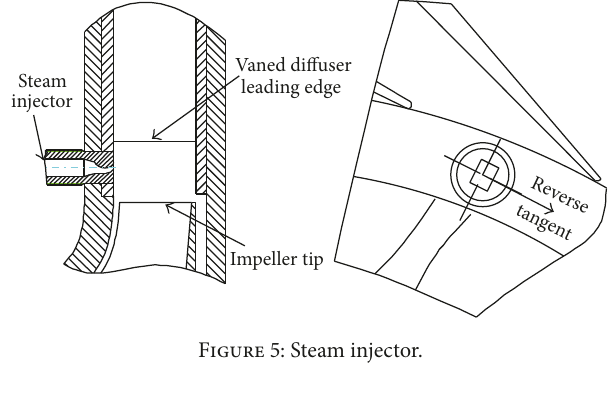
Figure 5: Steam injector.